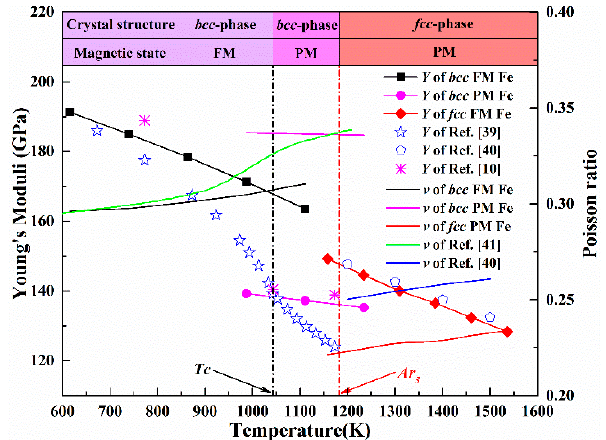
Figure 8. Relationship of average Young’s modulus and Poisson’s ratio of matrix phase with Figure8. RelationshipofaverageYoung’smodulusandPoisson’sratioofmatrixphasewithtemperature temperature for different lattice and magnetic structures, along with the available data from for di ff erent lattice and magnetic structures, along with the available data from References References [40,42].